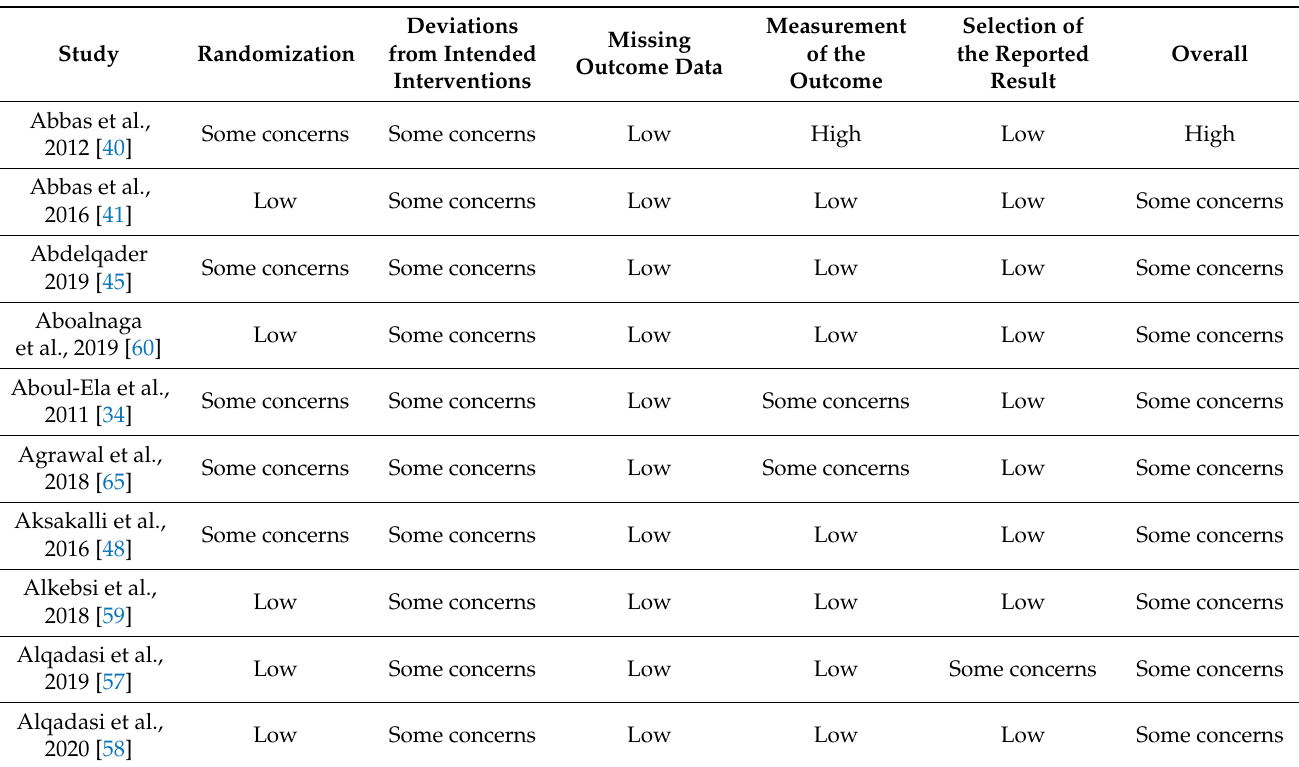
Table A3. Risk of bias of included RCTs with the RoB 2.0